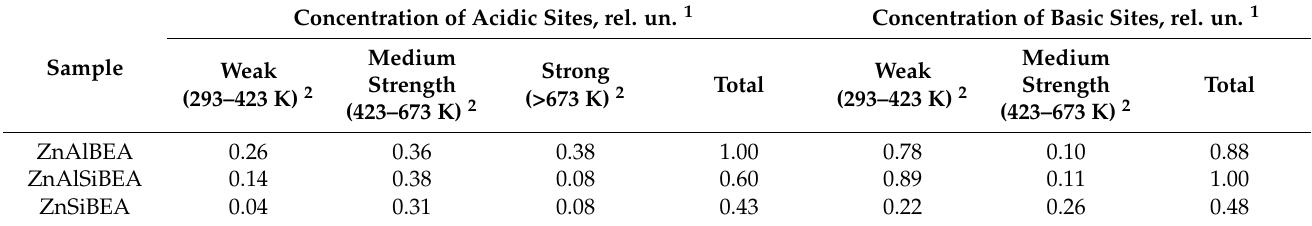
Table 4. Acid–base characteristics of zeolite samples of Zn-BEA according to TPD-NH 3 (CO 2 ) profiles. Concentration of Acidic Sites, rel. un. 1 Concentration of Basic Sites, rel. un. Sample